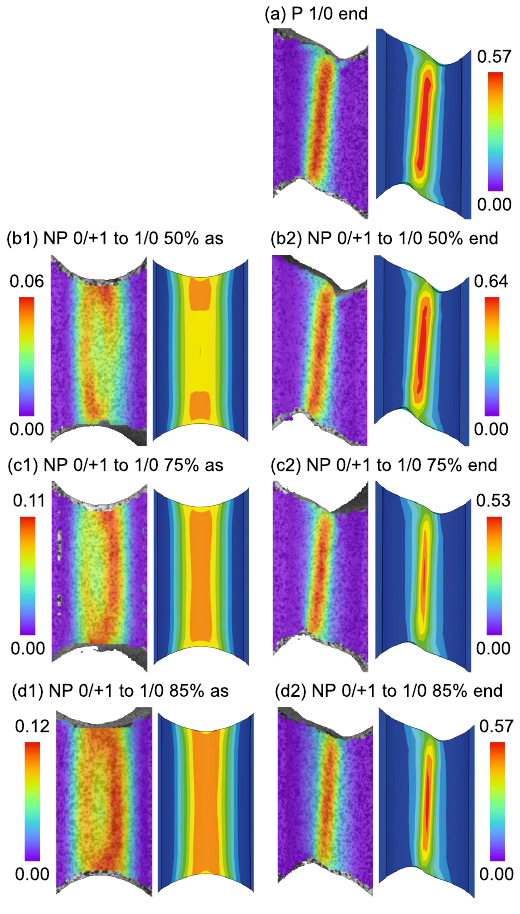
Figure 6. First principal strain by digital image correlation (DIC) ( left ) and numerical simula- tion ( right